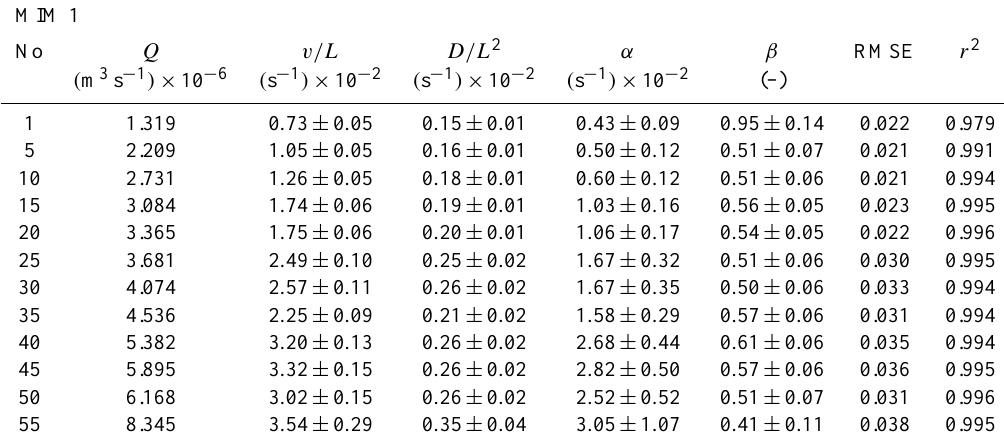
Table 1. Estimated values of parameters, RMSE, and determination coefficient r 2 for MIM at different injection flow rates in the fractured medium.